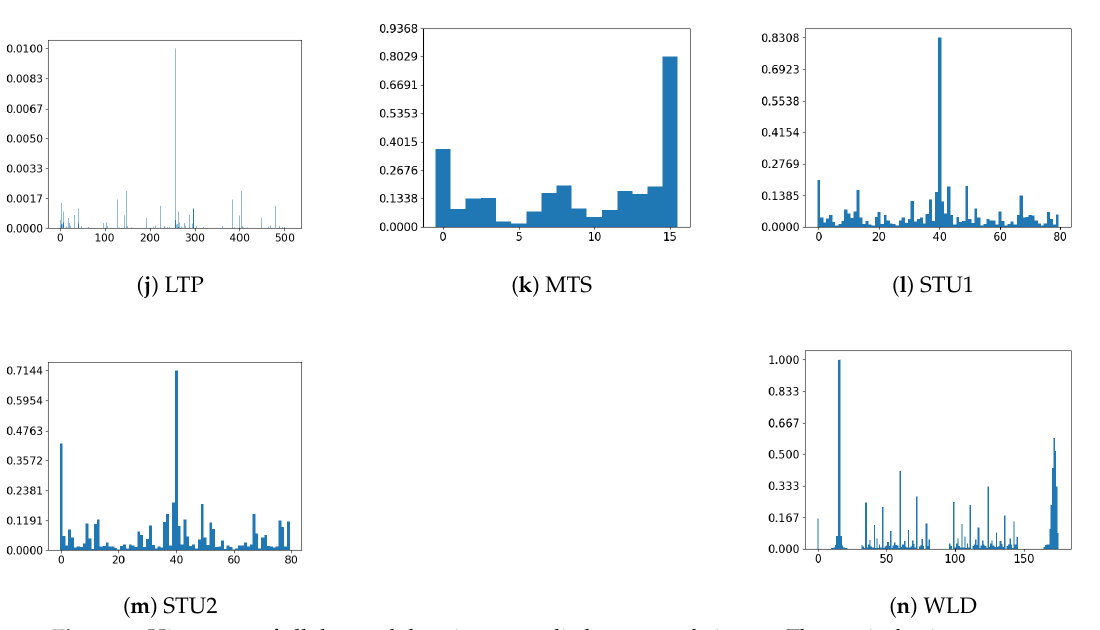
Figure 6. Histogram of all the used descriptors applied to a sample image. The vertical axis represents the number of occurrences of each texture unit normalized and the horizontal axis represents each of the texture units of the histograms. The descriptors are the ones that are part of D described at the beginning of Section